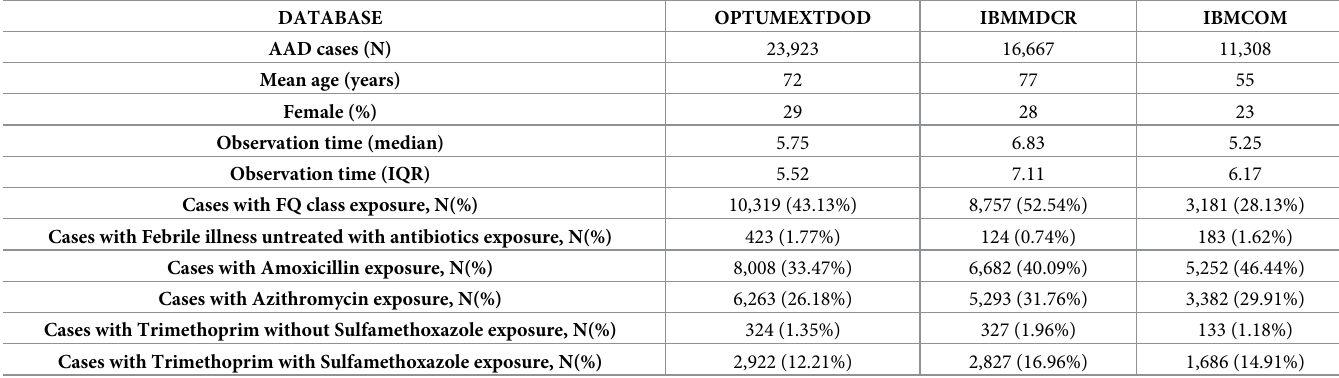
Table 1. Characteristics and exposure case count of distinct patients with AAD across each